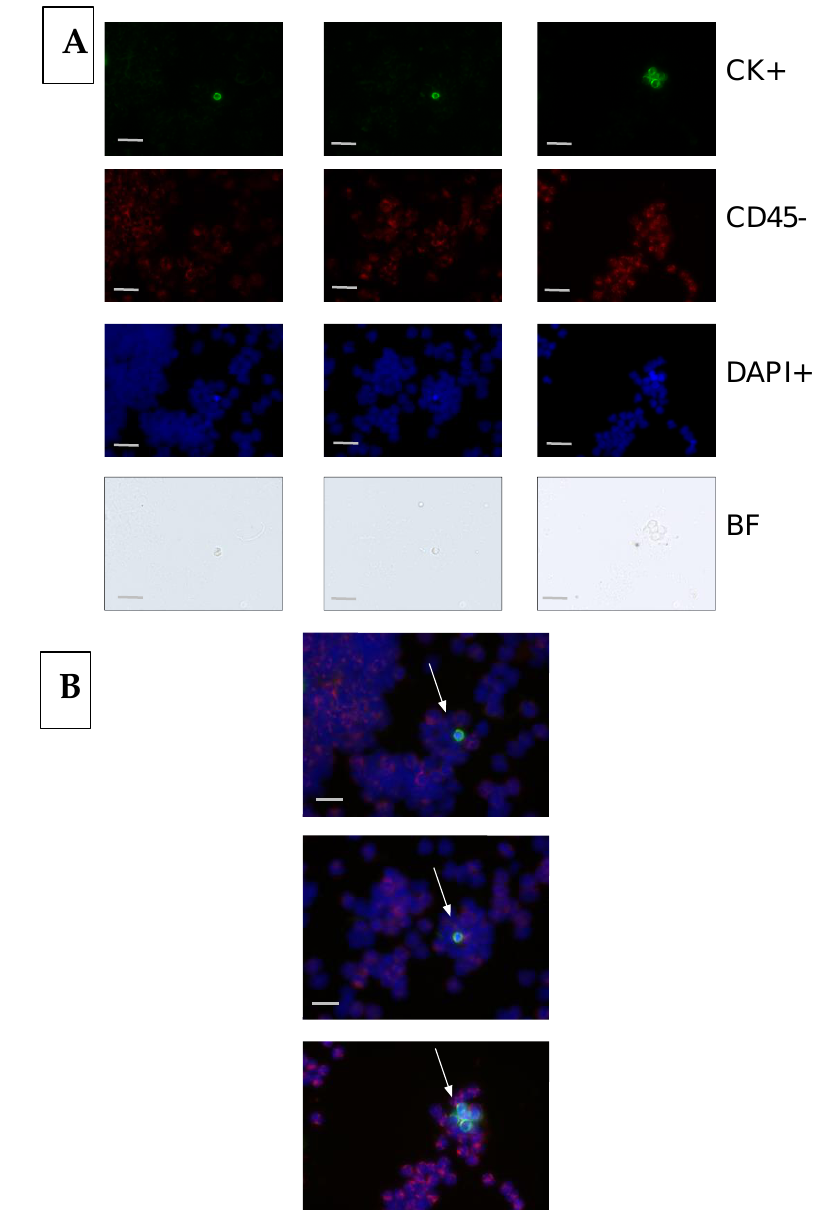
Figure 1. Image analysis of circulating tumor cells (CTCs) detected in the blood of esophageal cancer patients. Bar indicates 20 µ m. ( A ) Cells classified as a CTC: positive for cytokeratin (CK), negative for CD45, positive for nuclear staining, and identified as an intact cell through the brightfield (BF) image. ( B ) Composite image of a CTC cluster from esophageal cancer patients.